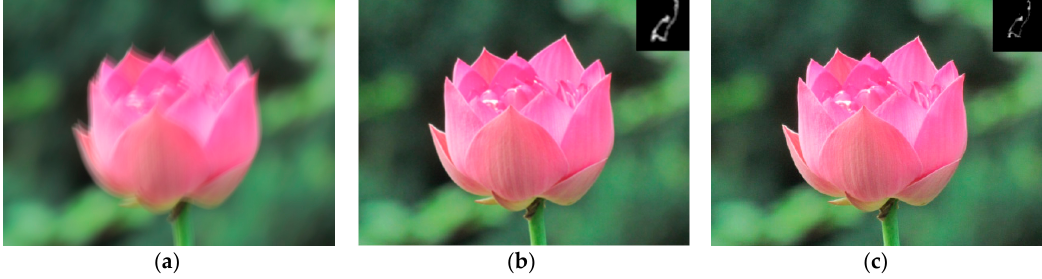
Figure 3. The restoration of a synthetic blurred image. ( a ) blurred image; ( b ) restored image and estimated blur kernel; and ( c ) ground truth image and blur kernel.